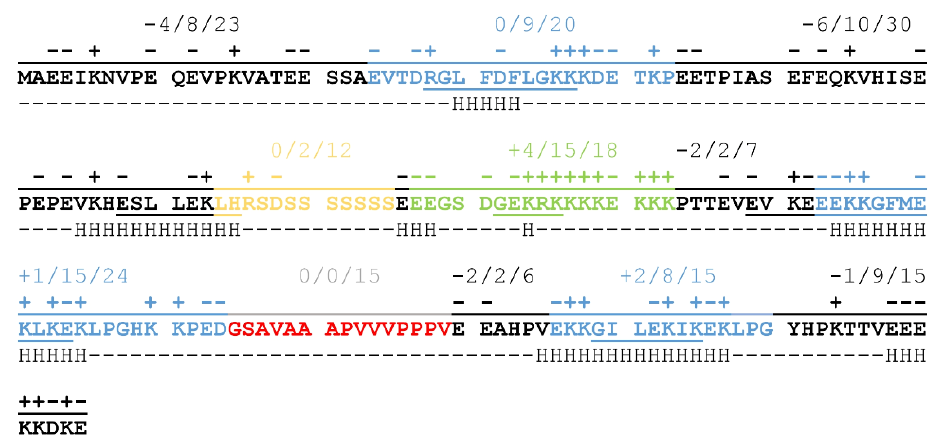
Figure 1. Conserved segments, charge distribution, in silico, and experimental α -helical propensities of the ERD14 protein. Conserved regions: Ka-, Kb-, Kc- (blue), S- (yellow), Chp- (green), and H-segment (red) indicated in the sequence of ERD14. In addition to individual charges above the regions, net charge/number of charged side chains/length of regions summed up. Underlined letters show residues with α -helical propensity calculated from nuclear magnetic resonance (NMR) chemical shifts [9,16] by δ 2D method [17]. Below the residues, H indicates the α -helical propensity estimated by in silico PredictProtein analysis [18–20].